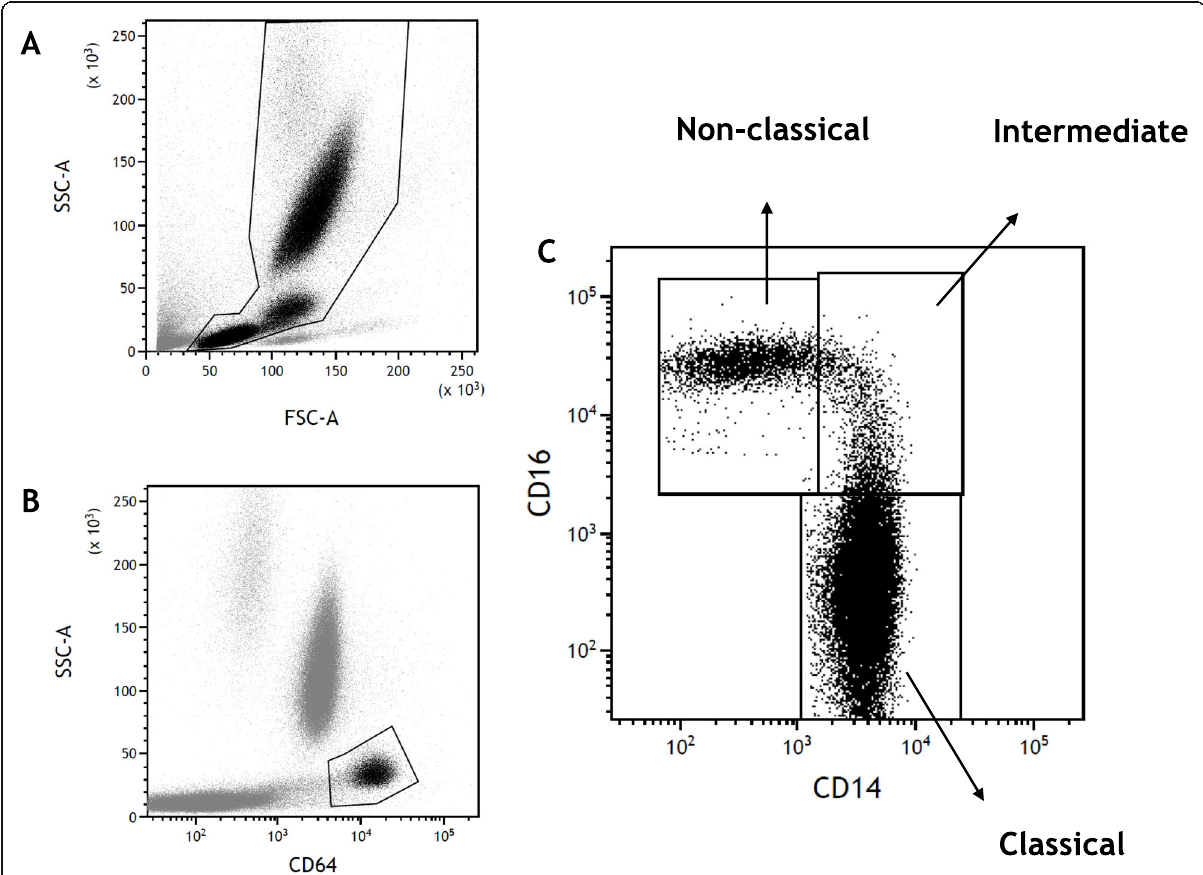
Fig. 1 Identification of monocyte subpopulations. a Cells were gated based on FSC (forward scatter) versus SSC (side scatter) distribution and doublets were excluded. b Monocytes were gated based on cell size and complexity, as well as CD64 expression. c Monocyte subpopulations were plotted in a CD14 versus CD16 expression in a representative healthy